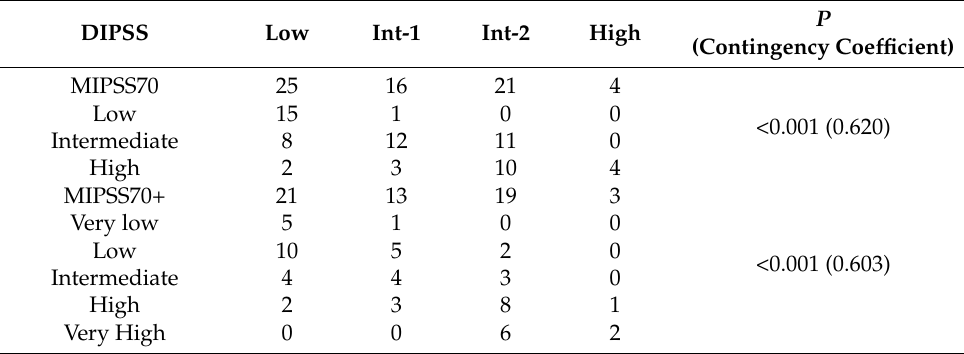
Table 5. Comparison of risk groups in primary myelofibrosis (PMF)